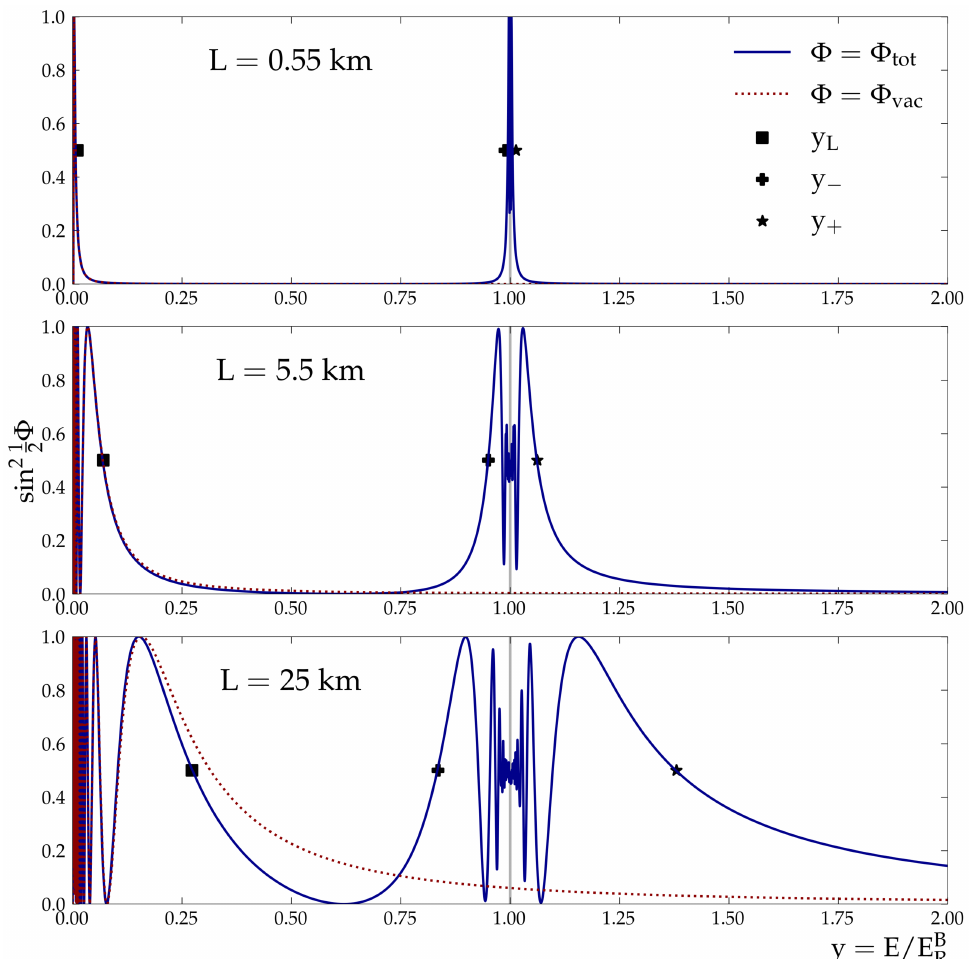
Figure 5 . The oscillatory factor as function of energy y for three different values of baselines L . We take r = 1 . 6 and (cid:15) = 0 . The dotted lines correspond to the oscillatory factors for pure vacuum oscillations ( r = 0